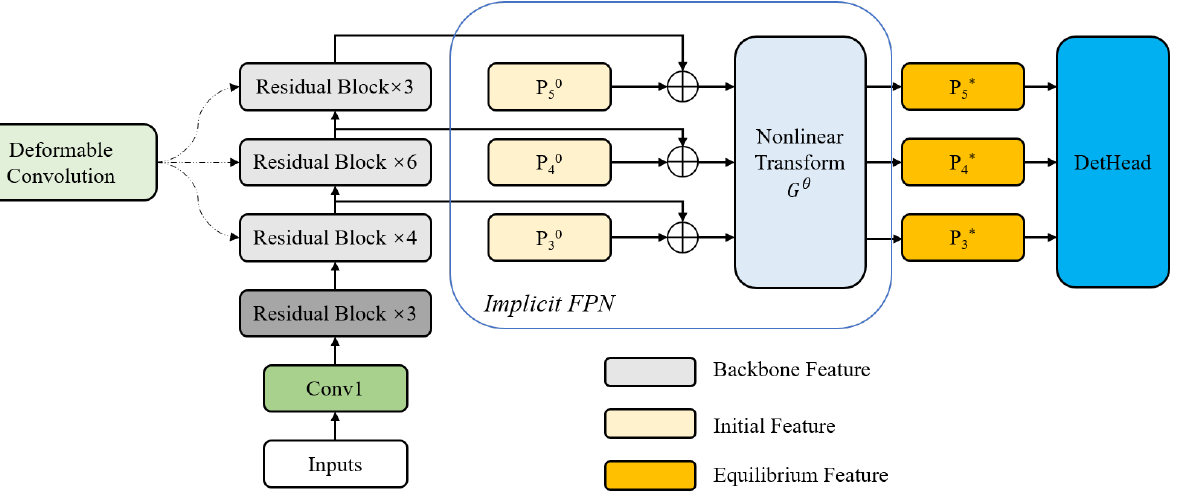
Figure 8. Architecture of object detector with implicit feature pyramid network. The ResNet50 [25] is adopted as the backbone network to extract backbone features. The initial pyramid features, which are all initialized to zeros, together with the backbone features are input to the i-FPN. In the i-FPN, the nonlinear transformation function G θ is employed to construct the implicit function and the equilibrium feature pyramid is injected into detection head to generate the final detection